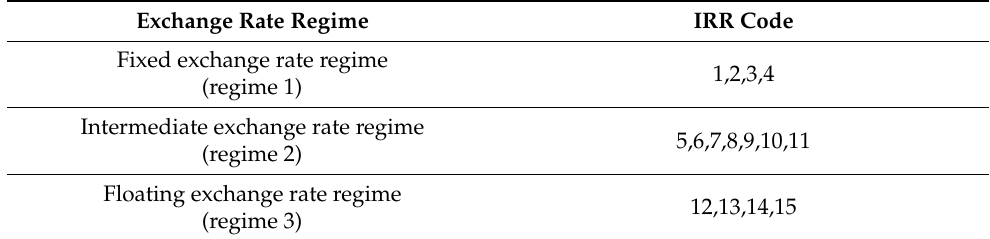
Table 2. Classification of exchange rate